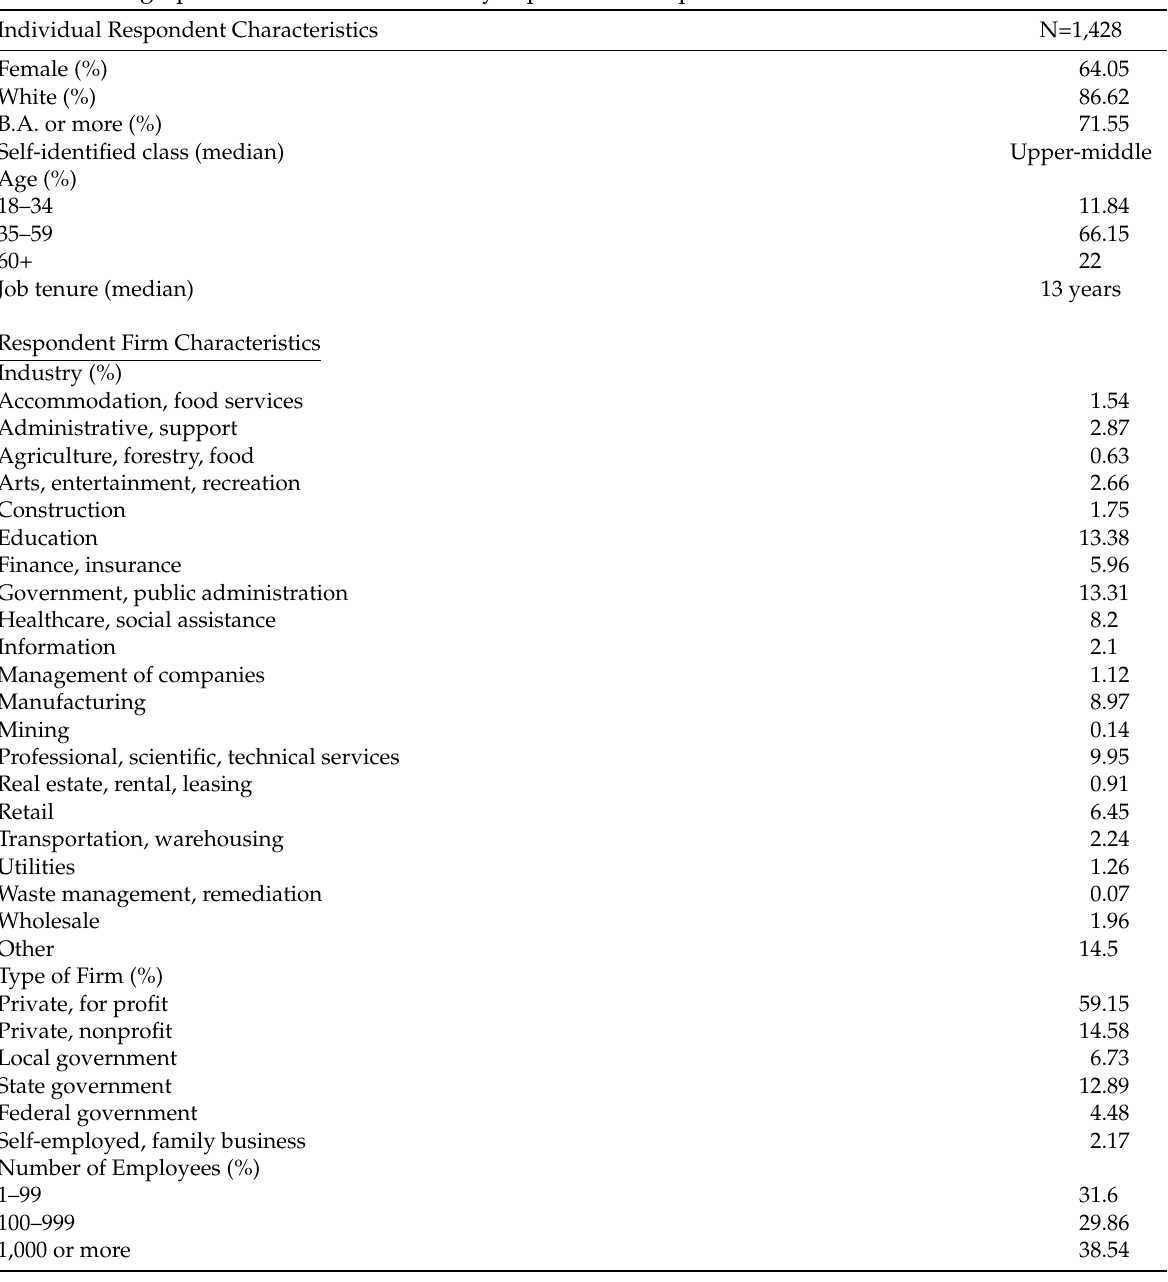
Table 4: Demographic characteristics of survey experiment